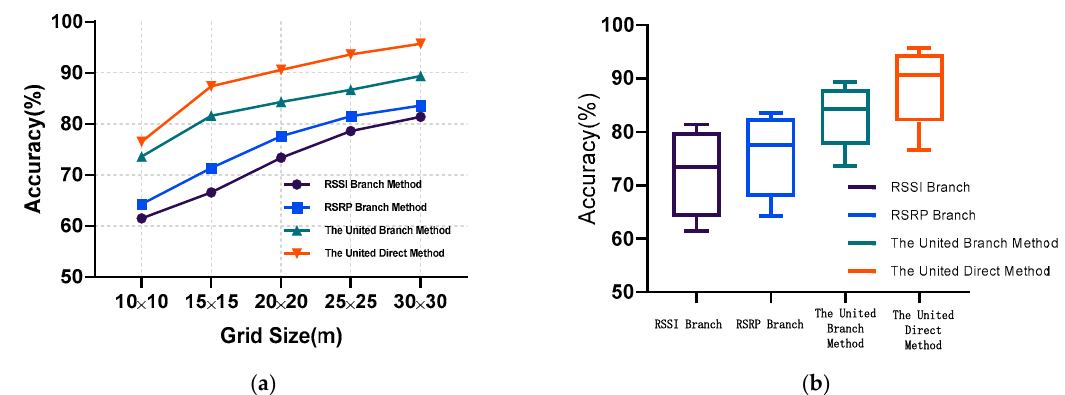
Figure 9. Performance comparison of different localization methods: ( a ) positioning performance of methods with respect to different grid sizes; ( b ) average and range of positioning accuracy of methods over all grid sizes.